Question: Express in one sentence what the figure is showing.
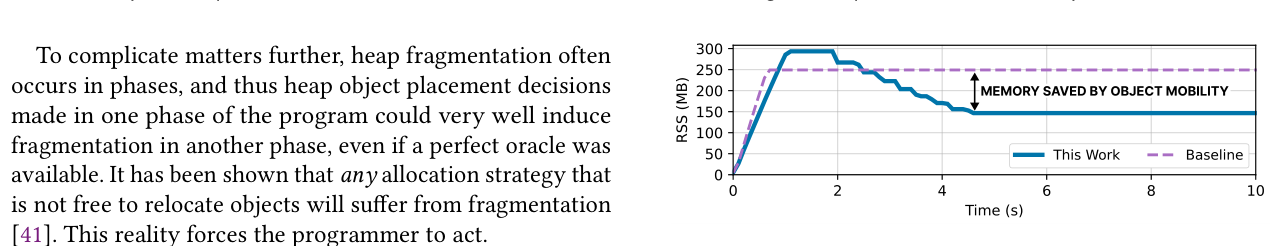
Answer: Through object mobility, Alaska can save consid- erable memory—up to 40% in Redis.